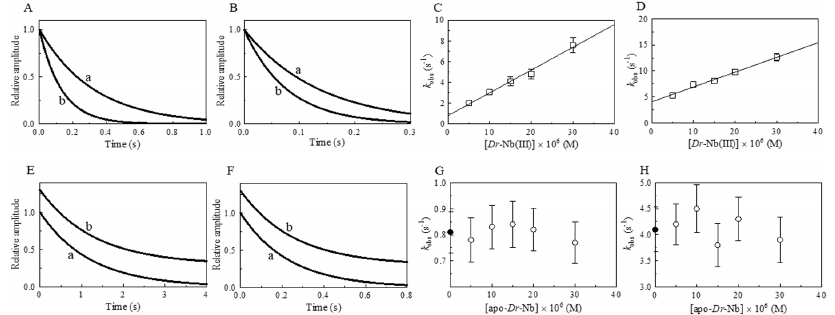
Figure 1. Effect of Dr -Nb(III) on the kinetics for peroxynitrite isomerization, at pH 5.8 and 22.0 °C. ( A ) Averaged time courses of the Dr -Nb(III)-catalyzed isomerization of peroxynitrite in the absence